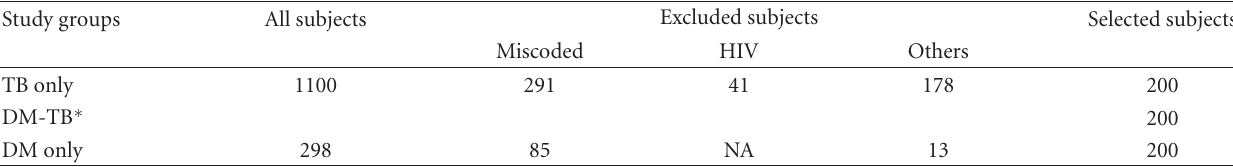
Table 1: Patient distribution among study centers.